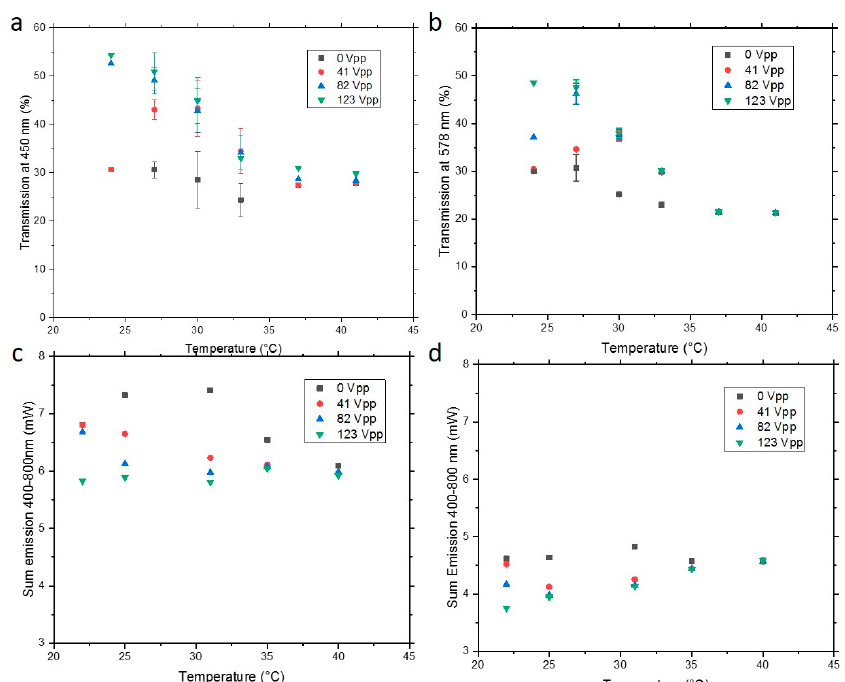
Figure 3. Transmission at the peak absorption of the dye at increased temperature and voltage for planar cells containing ( a ) Dye 1; ( b ) Dye 2. Summation of emission spectra (from the edge with dyes aligned parallel to the LC alignment) between 400–800 nm at increased temperature and voltage for planar 5 × 5 cm 2 containing ( c ) Dye 1; ( d ) Dye 2.